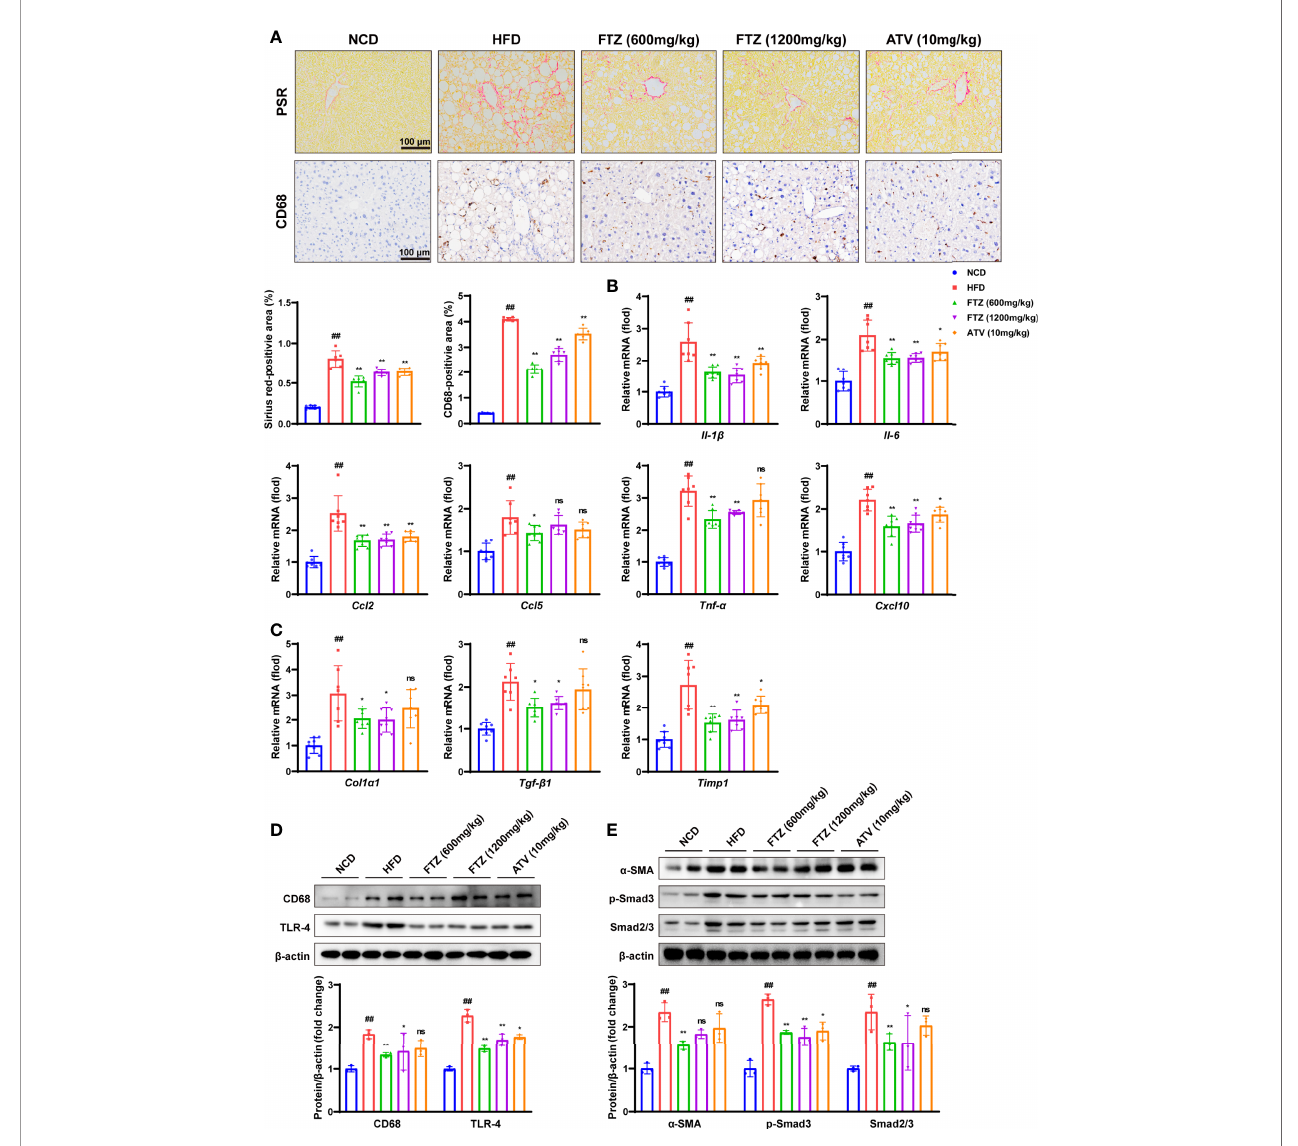
FIGURE 4 | Effects of FTZ on metabolic in fl ammation and fi brosis in the livers of mice. (A) Representative images showing PSR and immunohistochemical staining of CD68 staining in the livers of the indicated mice (n=6). (B) Relative mRNA levels of in fl ammatory genes in the livers of the indicated mice (n=7 – 8). (C) Relative mRNA levels of pro fi brotic genes in the livers of the indicated mice (n=7-8). (D) The expression of CD68, TLR-4, and b -actin was analyzed by Western blotting. b -actin served as a loading control (n=3). (E) The expression of a -SMA, p-Smad3, Smad2/3, and b -actin was analyzed by Western blotting. b -actin served as a loading control (n=3). Data are represented as means ± SEM. # indicates a signi fi cant difference between the NCD group and the HFD group (t-test); * indicates a signi fi cant difference between the FTZ (600 mg/kg)/FTZ (1,200mg/kg)/ATV (10 mg/kg) group and the HFD group (one-way ANOVA). ## P < 0.01 versus NCD mice; * P < 0.05, ** P < 0.01 versus mice fed by HFD. ns indicates no signi fi